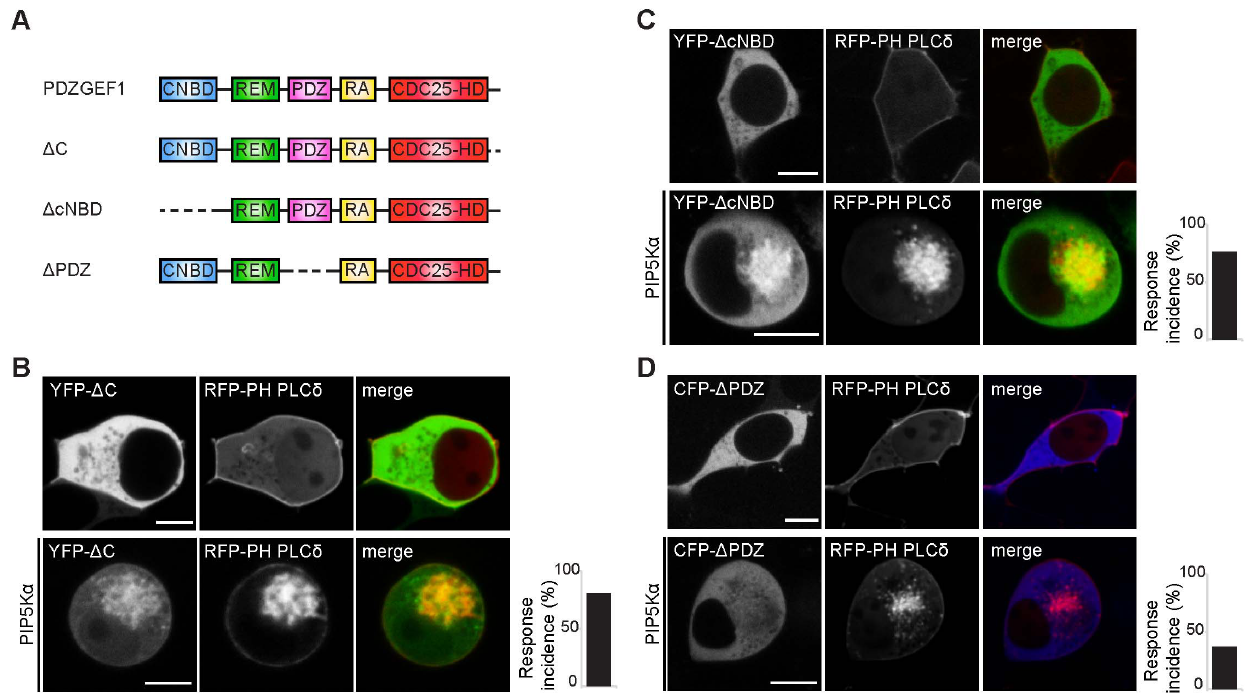
Figure 1. Characterization of the domain repsonsible for binding to phosphatidic acid. A. Domain architecture of PDZGEF mutants. cNBD: cyclic nucleotide binding domain; REM: Rap/Ras exchange motif; PDZ: post synaptic density protein (PSD95), Drosophila disc large tumor suppressor (Dlg1), Zonula occludens-1 protein (Zo-1); RA: Ras association domain; CDC25-HD: CDC25 homology domain. B, C. Mutants of PDZGEF either lacking the C-terminus (YFP- D C) or the cNBD domain (YFP- D CNBD) transfected in HEK293T cells are unable to associate with PA on vesicles in PIP5K a - stimulated cells. RFP-PH PLC d confirms production of PtdIns(4,5)P2 by PIP5K a which then recruits the PA-producing enzyme PLD. D. Lack of the PDZ domain (CFP- D PDZ) abolishes association of the protein with PA on PIP5K a -generated vesicles in HEK293T cells. The bar graphs show the percentage of cells showing vesicular localization of the protein in the presence of PIP5K a (8/10 cells for YFP- D C, 9/12 cells for YFP- D CNBD and 4/11 cells for CFP- D PDZ). All scale bars: 10 m